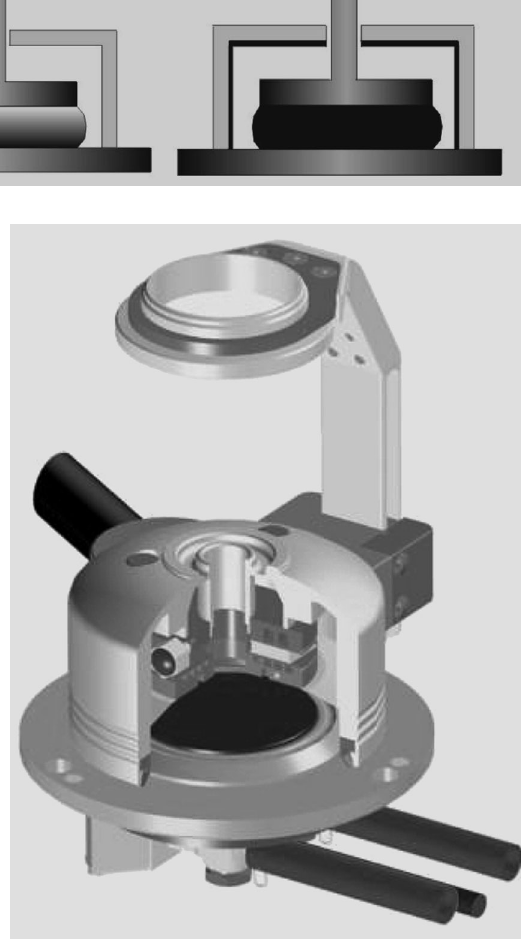
Figure 1 (above): Different setups of a Peltier system lead to differences in the temperature distribution across the sample: a) open system, b) system with insulating cover, c) Advanced Peltier System PTD 150 with an actively controlled hood. Figure 2a (left below): Image of the Physica Advanced Peltier System PTD 150. Figure 2b (right below): Sketch of the Physica Advanced Peltier System PTD 150.